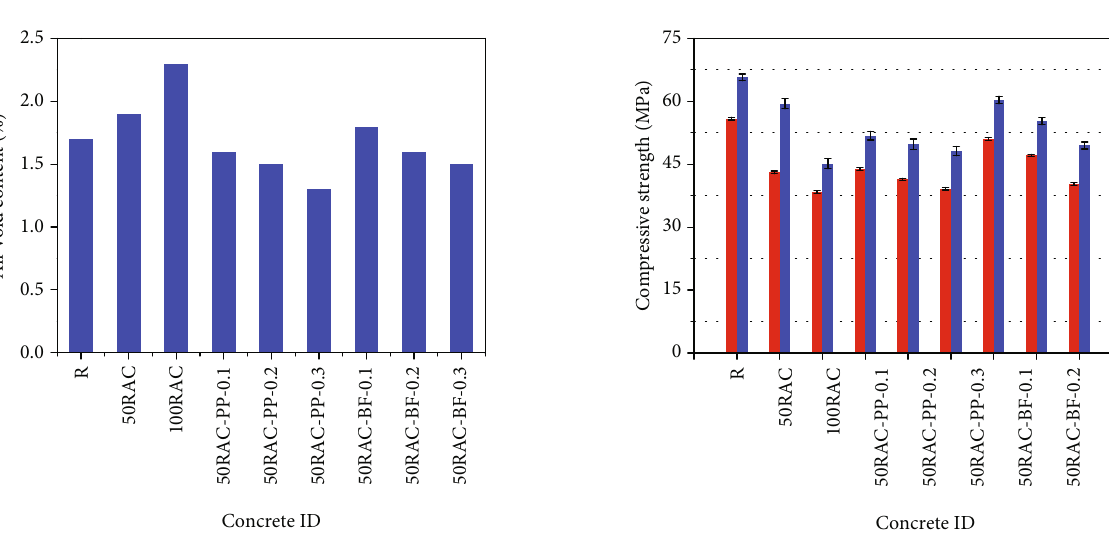
Figure 5: Air void content value of fresh concrete.